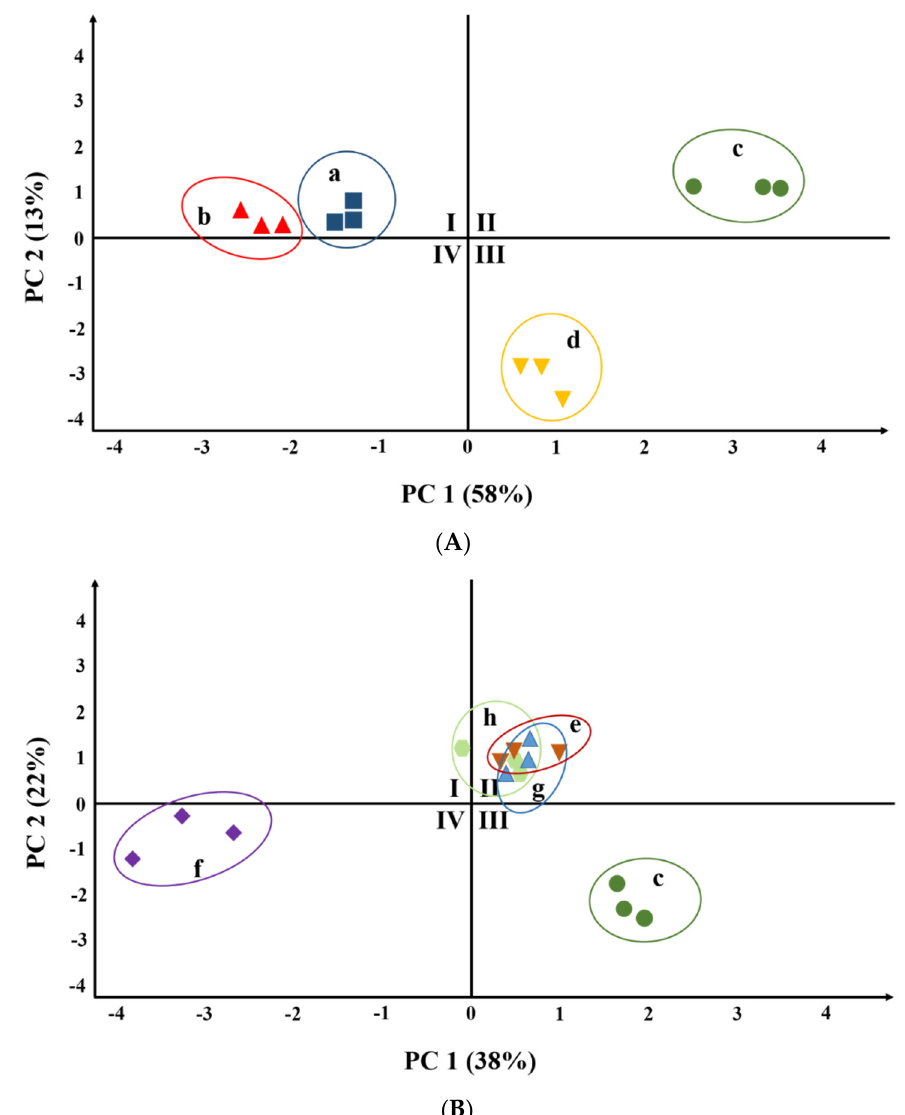
Figure 2. Gallery plot of the selected signal peak areas obtained from T. matsutake samples at different frying temperatures ( A ) and frying times ( B ): ( a ) 100 °C, 80 s; ( b ) 120 °C, 80 s; ( c ) 160 °C, 80 s; ( d ) 200 °C, 80 s; ( e ) 160 °C,40 s; ( f ) 160 °C, 60 s; ( g ) 160 °C, 100 s; and ( h ) 160 °C, 120 s.